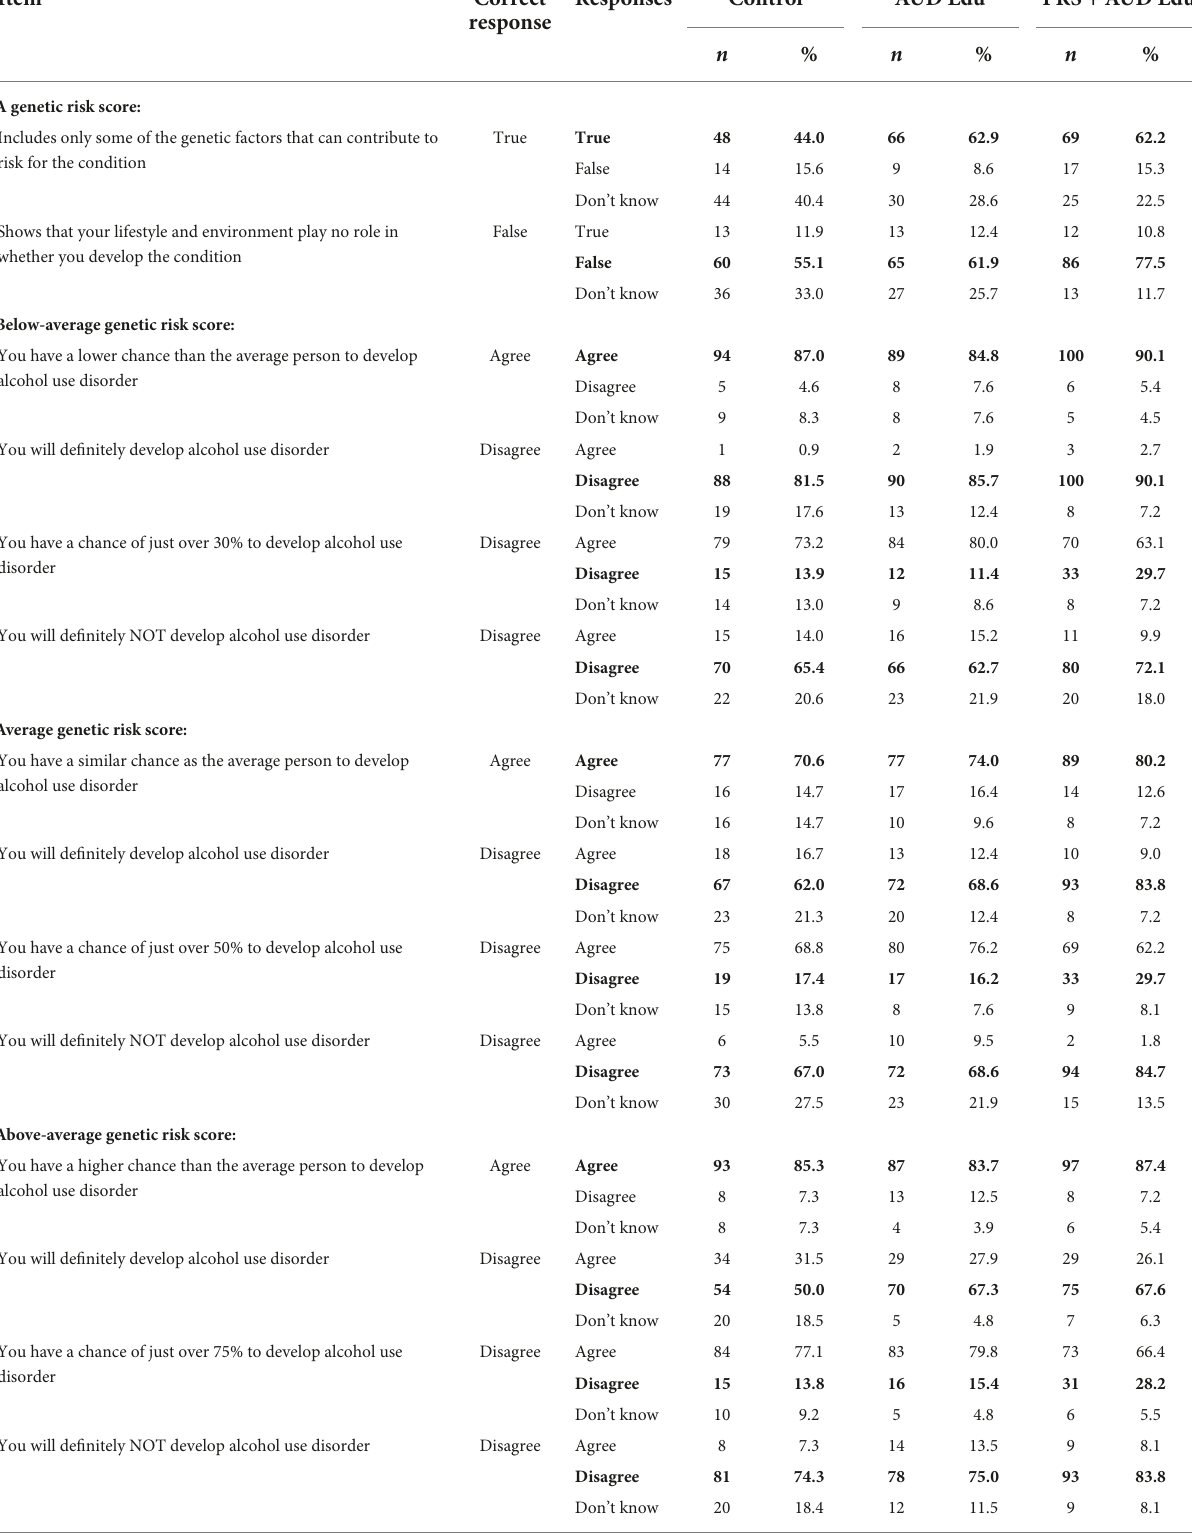
Correct Responses response